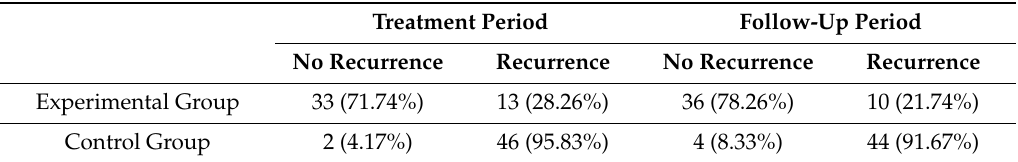
Table 1. Recurrence data of ingrown toenails in both groups. Treatment Period Follow-Up Period